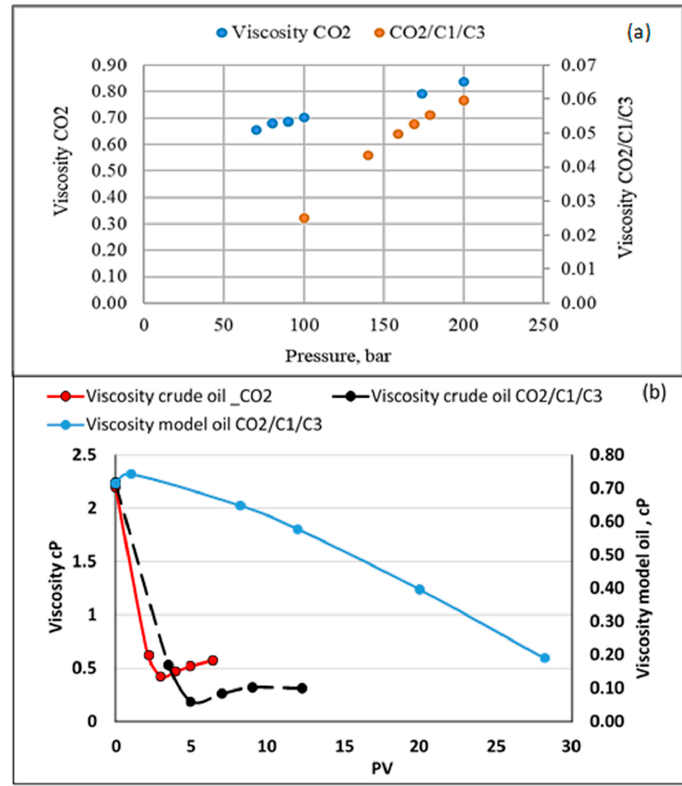
Figure 9. ( a ) Viscosity of the displacing fluids as a function of the experimental pressures and ( b ) comparison between viscosities of crude oil flooded with CO 2 and (CO 2 /C1/C3) CO 2 and the viscosity of model oil flooded with (CO 2 /C1/C3).